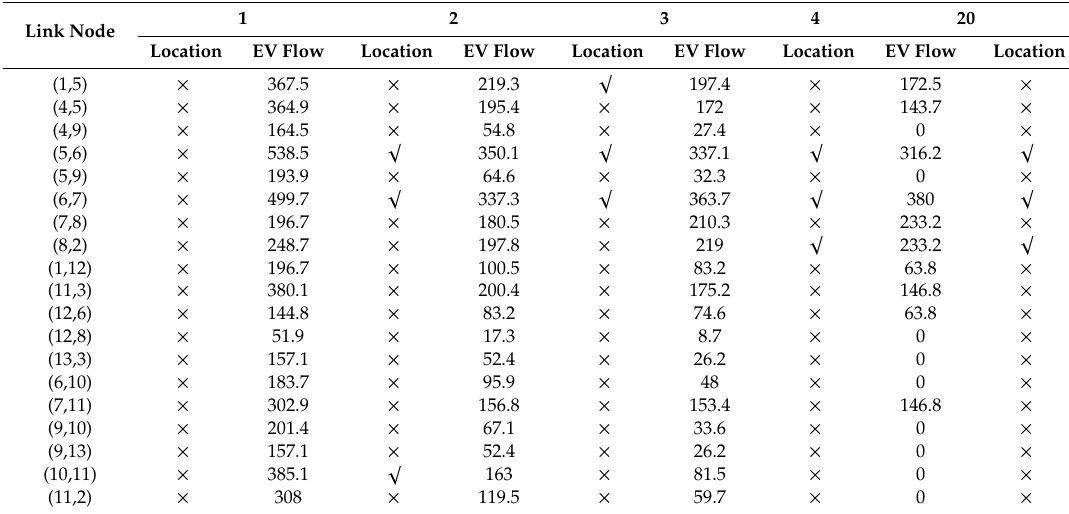
Table 3. The charging facility locations and Electric Vehicle (EV) flows